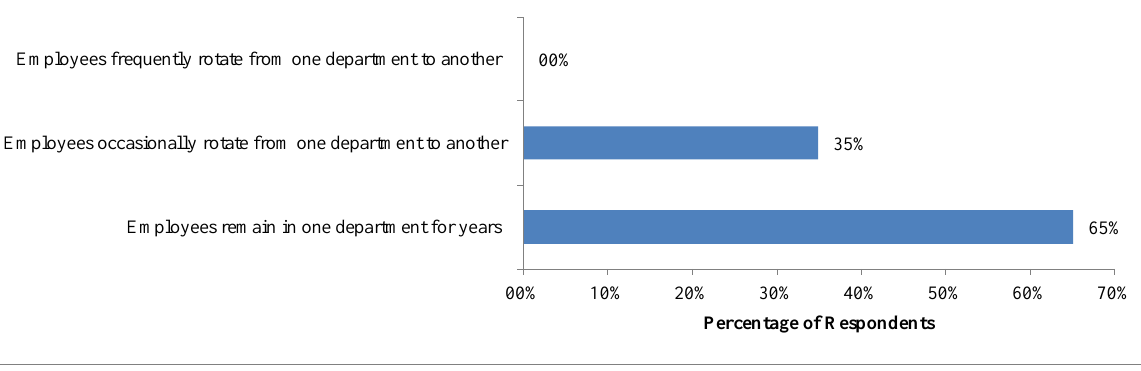
Figure 5: Respondents view of Job Rotation